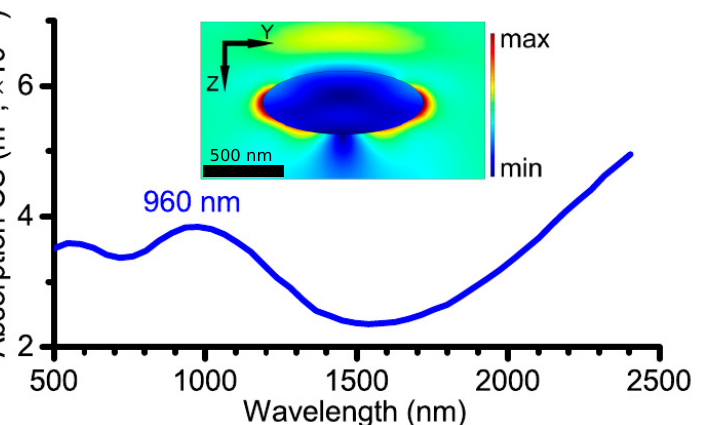
Figure 4. Simulated absorption CS of large spheroidal particle with semiaxes of 500, 200 and 200 nm. Inset: electric field intensity map at quadrupole resonance wavelength, 960